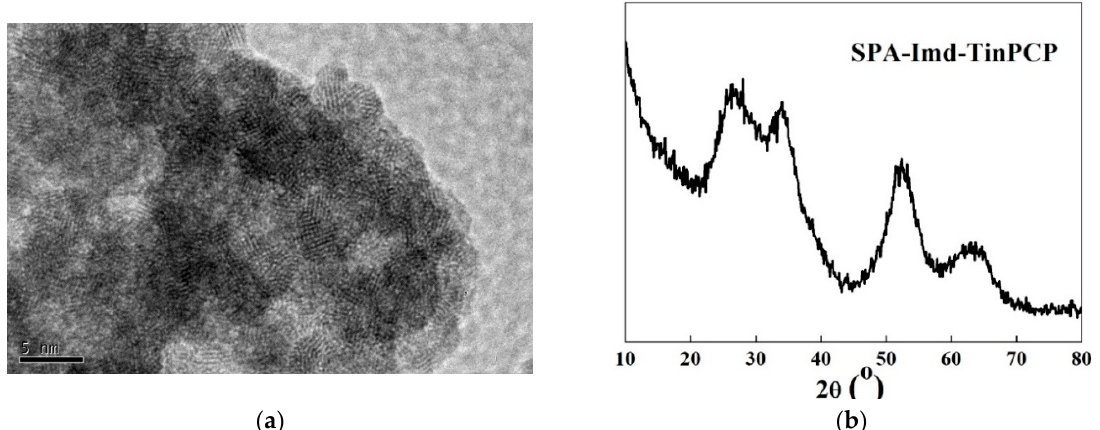
Figure 1. TEM image ( a ) and XRD pattern ( b ) for SPA-Imd-TinPCP.